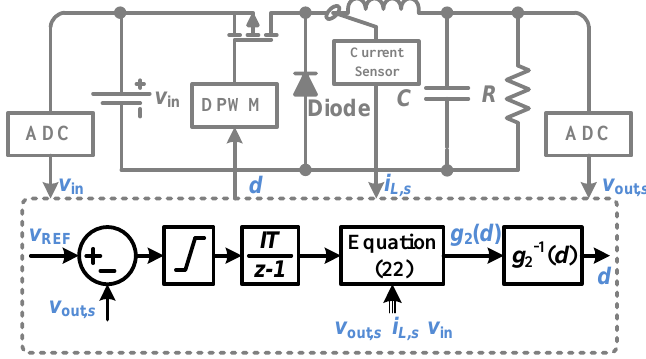
Figure 9. Practical DPVP controller with integral compensation and eliminated DPWM saturation.